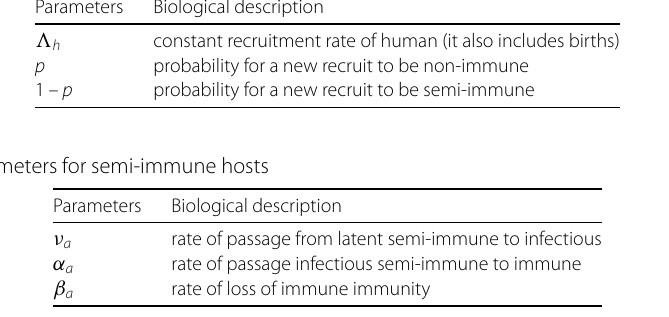
Table 5 Contact parameters between non-immune, semi-immune and mosquito Parameters Biological description